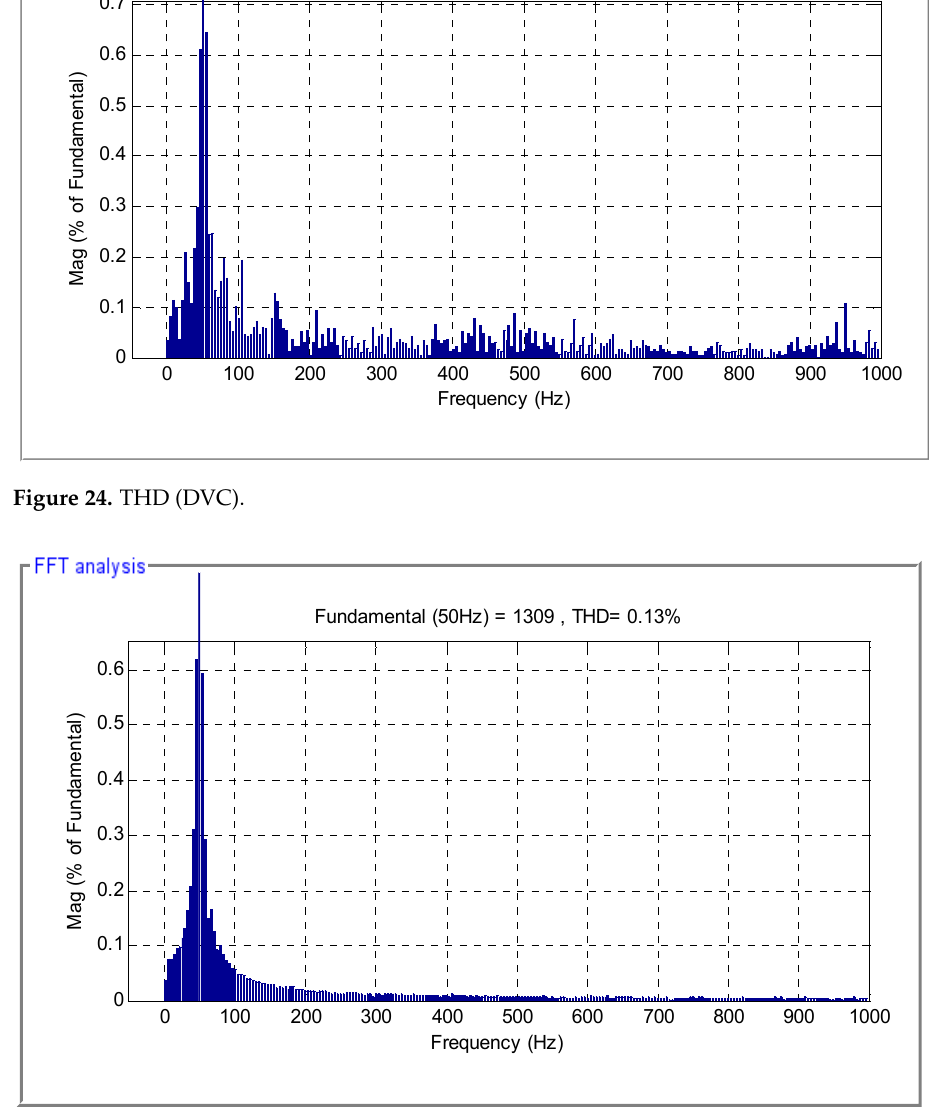
Figure 25. THD (NDVC-FPWM).